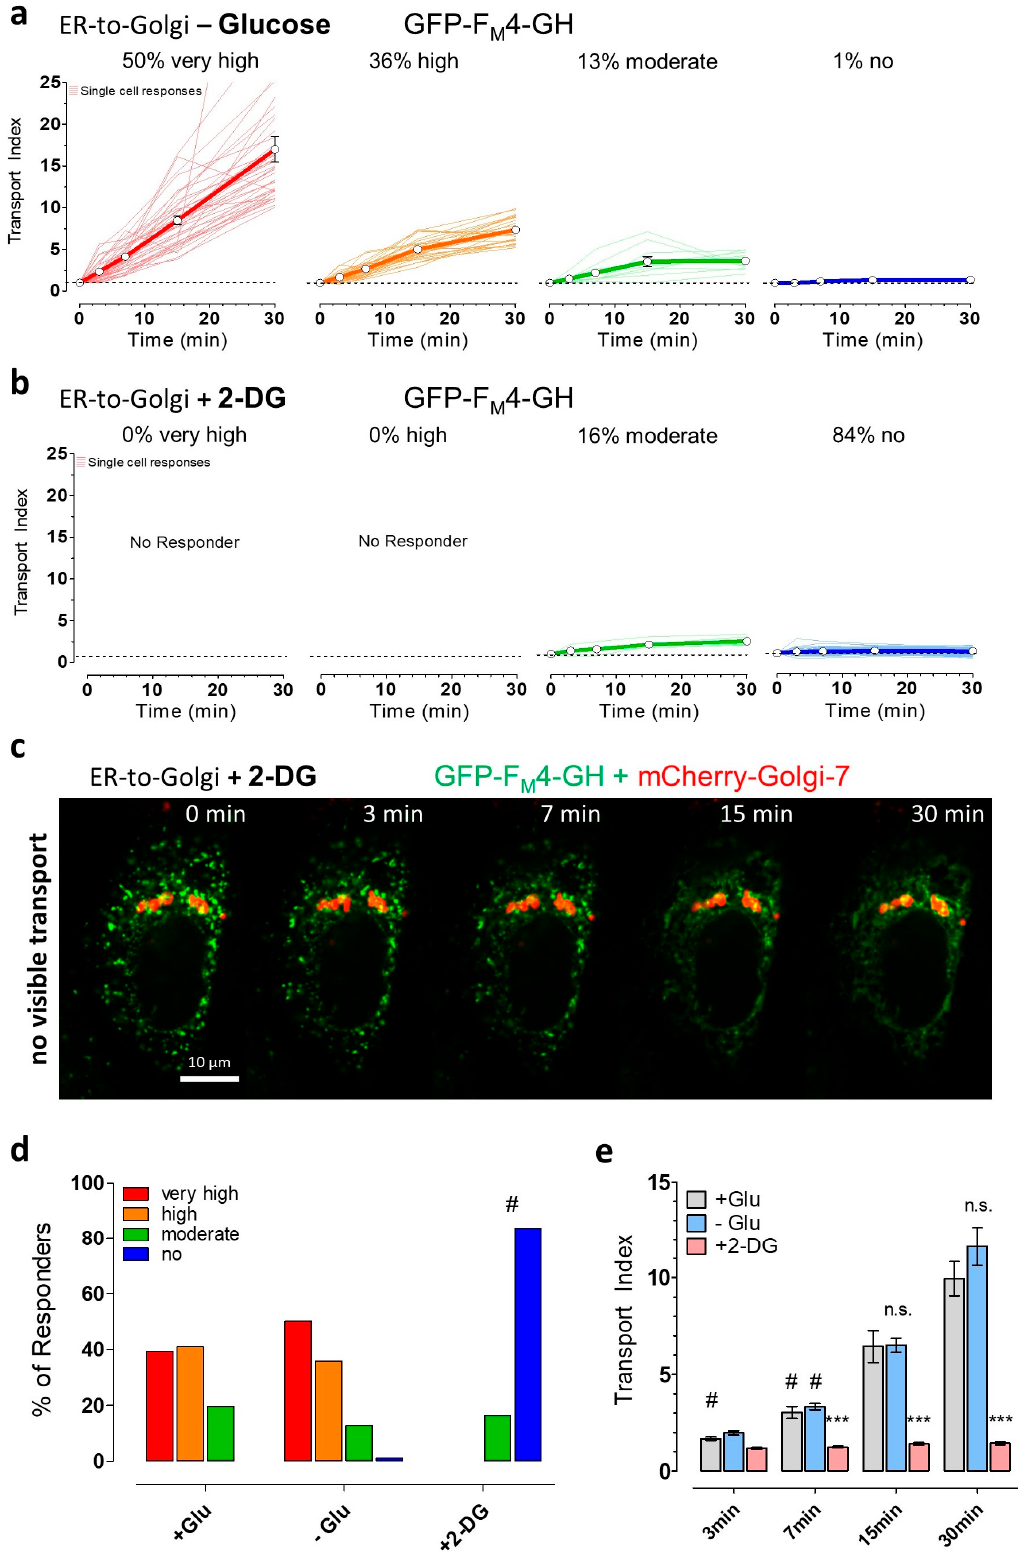
Figure 3. ER-to-Golgi transport of soluble cargo is facilitated by short-term glucose starvation but impaired by 2-DG. ( a ) ER-to-Golgi transport of GFP-F M 4-GH in glucose-deprived single HeLa cells (n = 78 cells from 3 independent experiments) showing very high (red, transport index at 30 min > 10), high (orange, transport index > 5, < 10), moderate transport index (green, transport index > 2, < 5), and no transport (blue, transport index <2). Cells were treated with buffer without glucose for 30 min prior